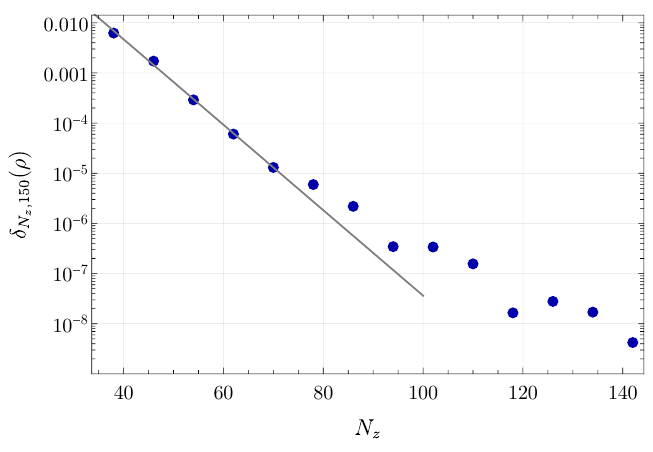
( ρ ) for the z = 0 plane at the collision time t = 3 as a function o the number of Figure 18 . δ N z , 150 points in the z direction. The gray line is a fit to the first five points, with equation 11 . 96 e − 0 . 196 N z .